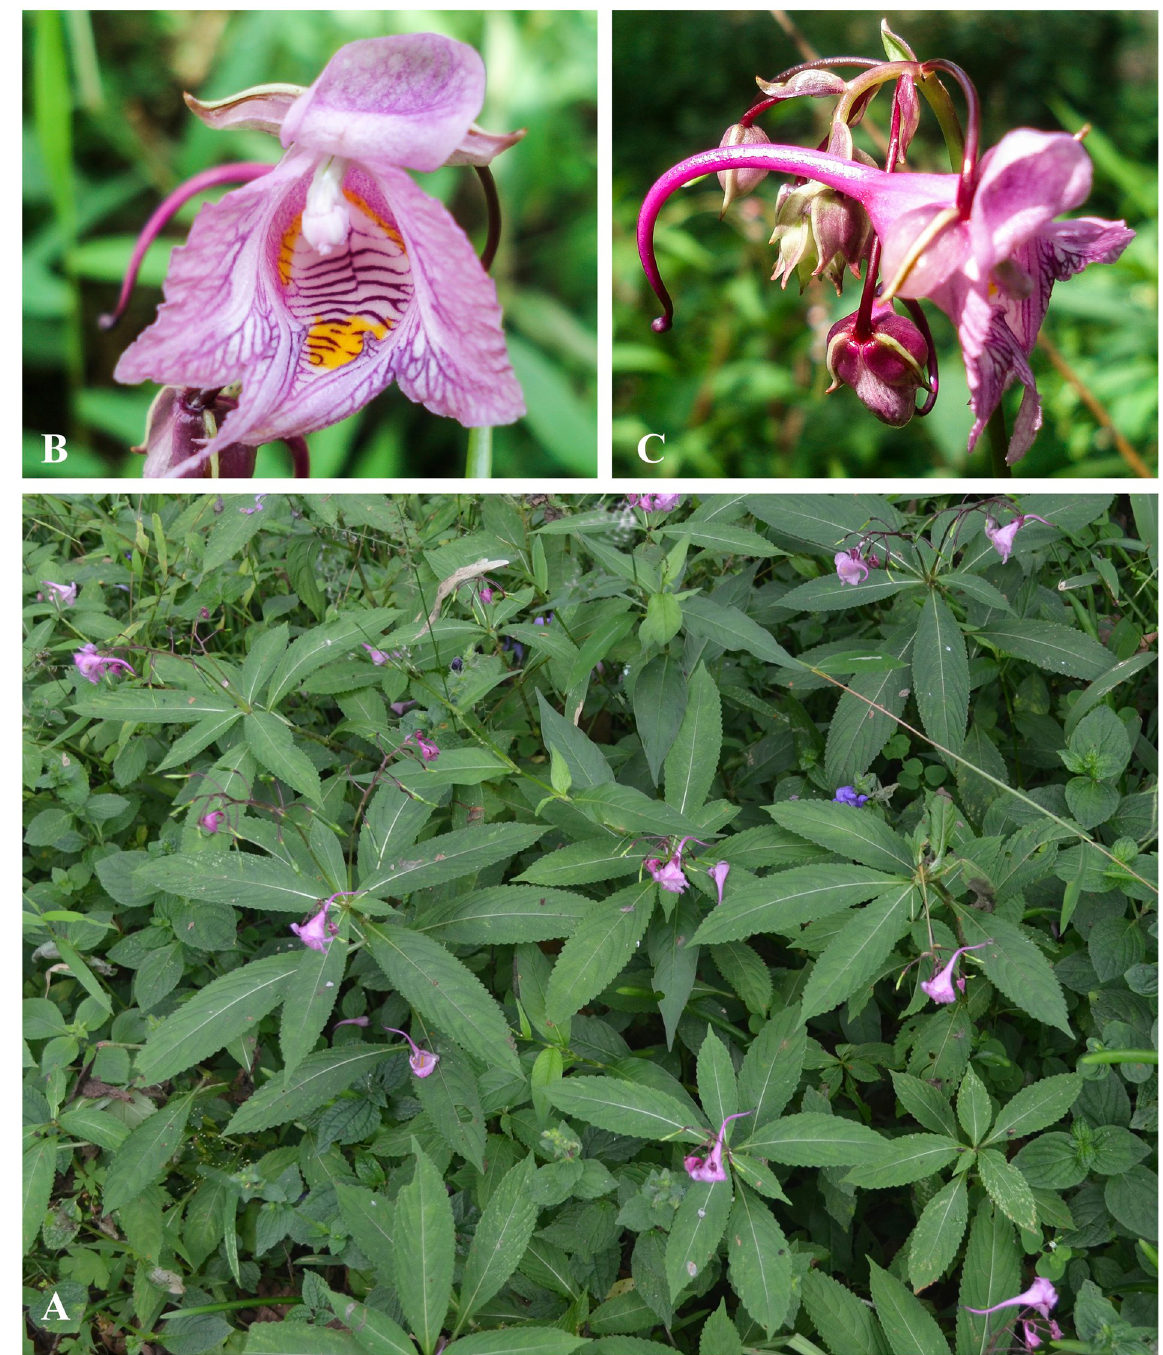
Fig 17. Impatiens insignis A. Flowering plant; B. Flower (front view); C. Flower (side view). Photographs by Bhakta Bahadur